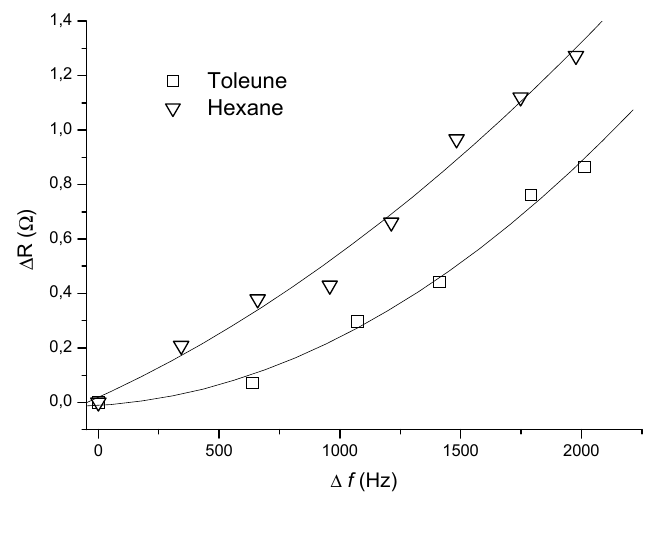
Figure 5. ∆ R against ∆ f showing discrimination between